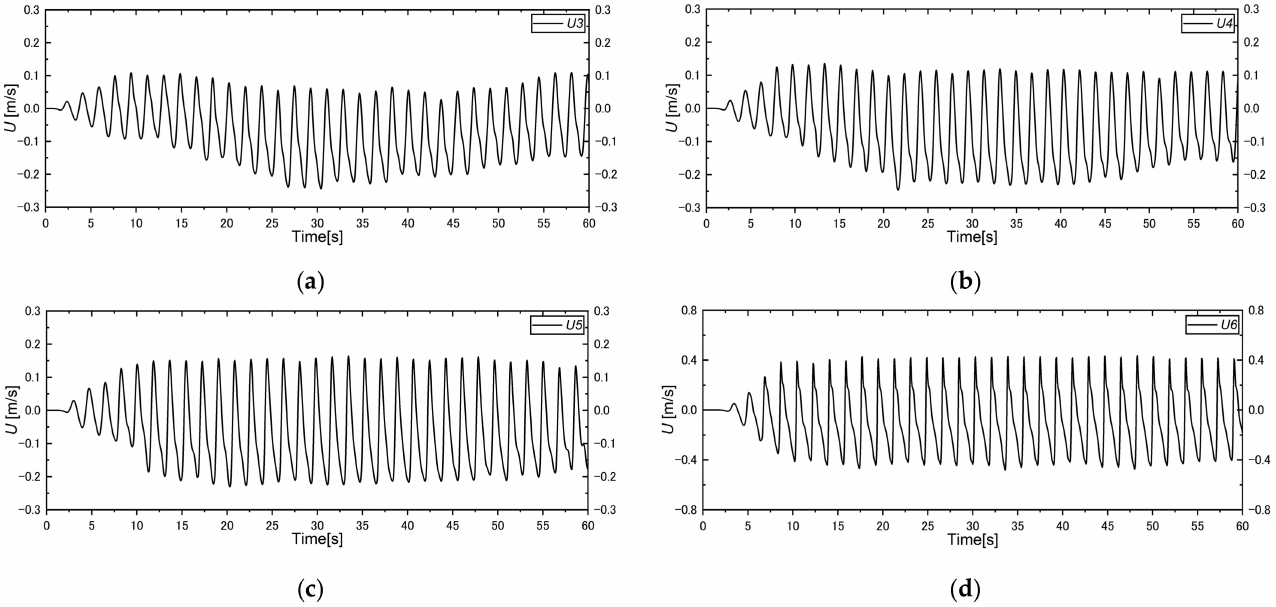
Figure 13. Variation in cross-shore velocity profiles for cross-section 1 at ( a ) U3 ( r = 300 cm), ( b ) U4 ( r = 336 cm), ( c ) U5 ( r = 369 cm), and ( d ) U6 ( r = 405 cm) in case 1 (T-1.80